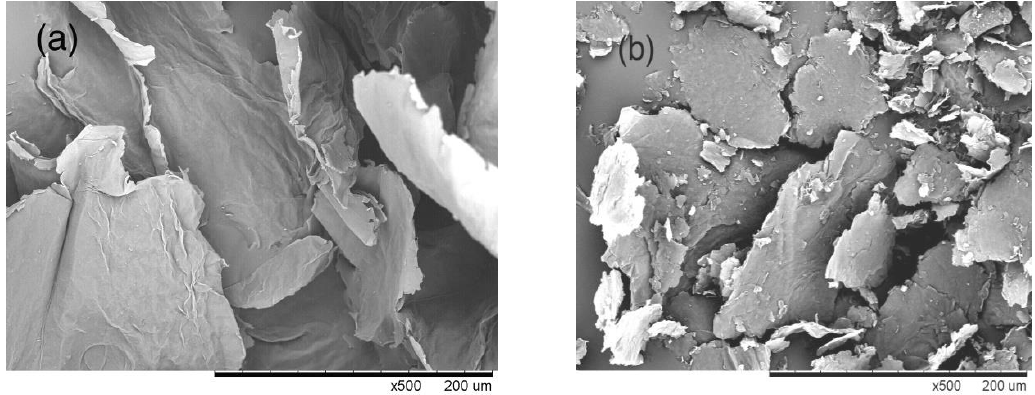
Figure 4. SEM images of ( a ) graphene oxide (GO); ( b ) active graphene (JZGO).